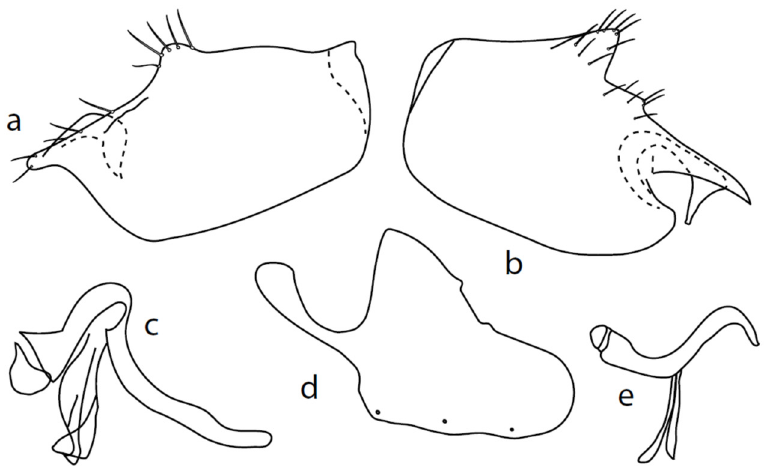
Figure 5. M. pallipes sp. nov.: ( a ) = right epandrial lamella, ( b ) = left epandrial lamella, ( c ) = phallus from left, ( d ) = hypandrium from right, ( e ) = postgonites from left. Female: similar to male. Head dichoptic, brownish black, light grey microtrichose. Eye smaller than in male, size differences between lower and upper facets are not so striking. Frons approximately 0.15 mm wide at middle. Ocellars longer than in male, ocellar triangle with two pairs of additional very small setae. Mesoscutum brown, grey microtrichose, with less distinct stripes in posterior view. Legs yellow, without conspicuous setae. Halter yellow. Abdomen with much shorter setose than in male.